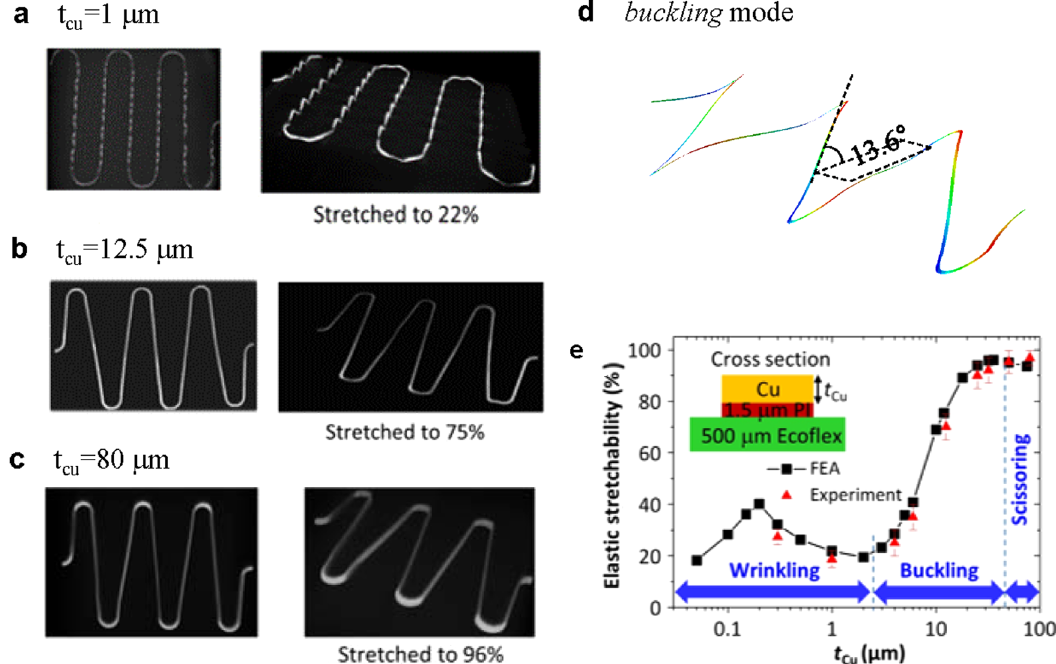
Fig. 8 Scanning electron microscopy image results associated with these regimes, illustrated at thicknesses a 1 μ m, b 12.5 μ m, and c 80 μ m, each stretched to the corresponding limit of elastic stretchability. d Experimental measurement and FEA study of the dependence of the elastic stretchability on the thickness of Cu interconnects, from 50 nm to 80 μ m. Three regimes of deformation occur in this range: wrinkling , buckling , and scissoring . (Reprinted with permission from ref.